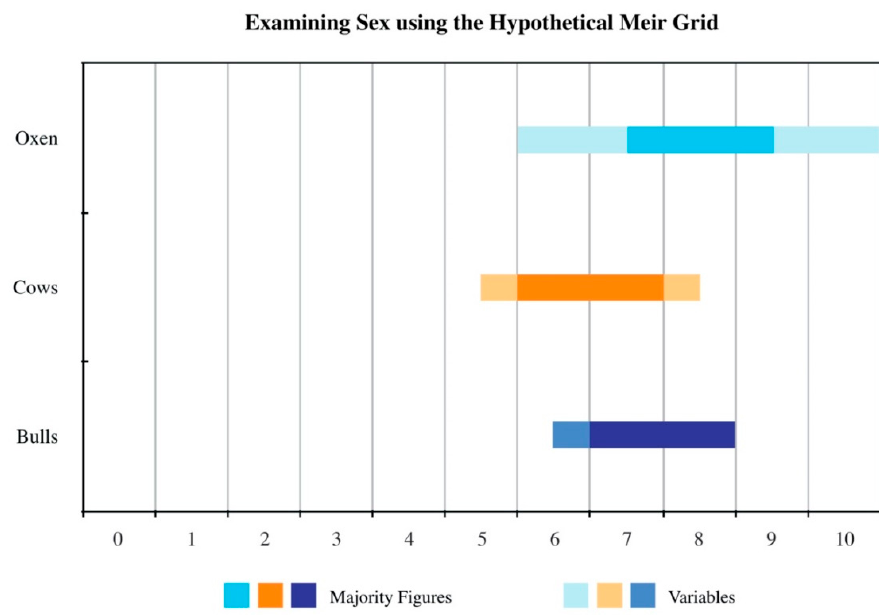
Figure 5. Examining sex using the hypothetical Meir grid.